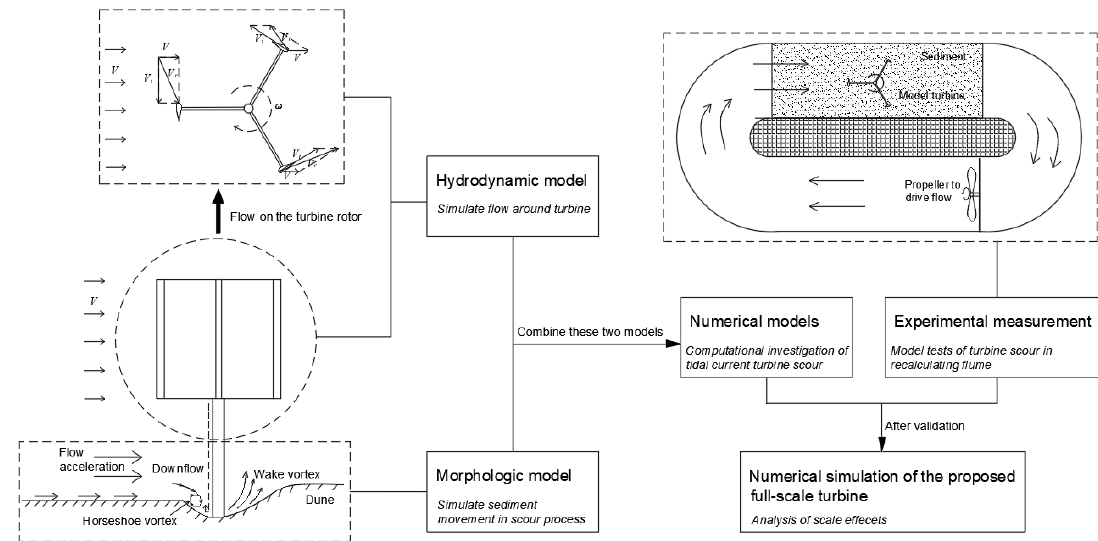
Figure 1. The research frame of this project.